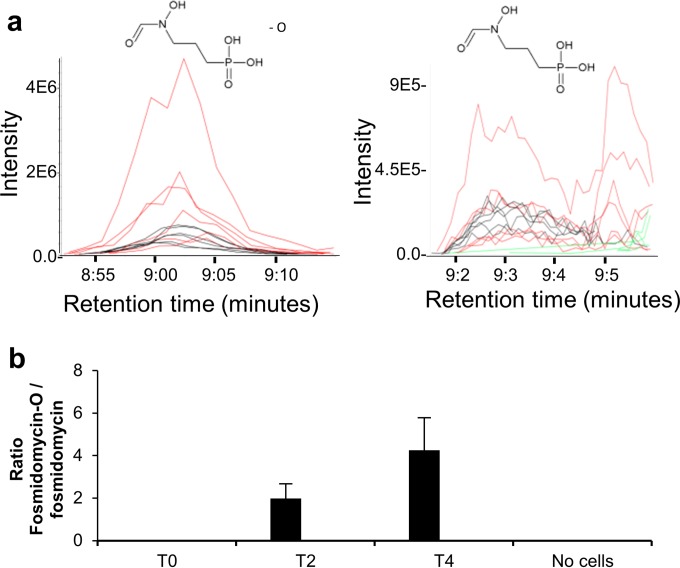
Fosmidomycin had a metabolite that appeared to be a cell-derived alteration of the drug. (a) Extracted peaks of deoxyfosmidomycin (left) and fosmidomycin (right). Black lines show the metabolite intensity at 2 h for each replicate, red lines show the intensity at 4 h, and green lines show the intensity in the 0-h control. (b) The ratio of deoxyfosmidomycin (fosmidomycin-O) to fosmidomycin increases during incubation with the cells. Error bars show standard deviations of the mean.